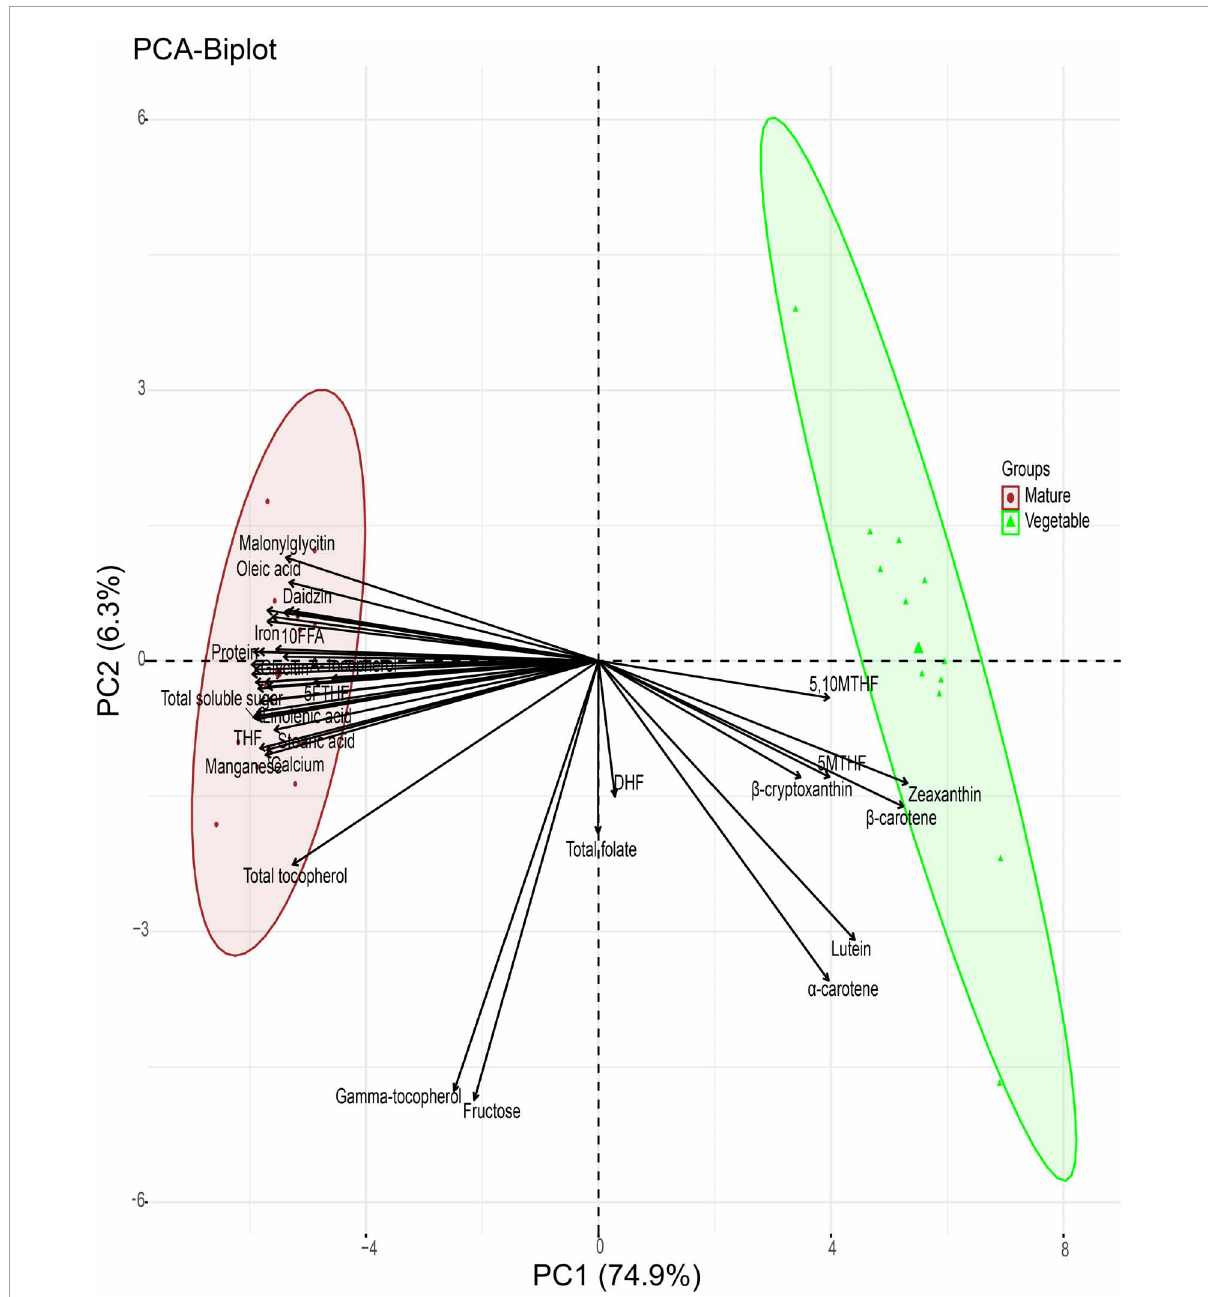
FIGURE7 Principal component analysis (PCA) of soybean cultivars and quality traits (FW) at the vegetable and mature